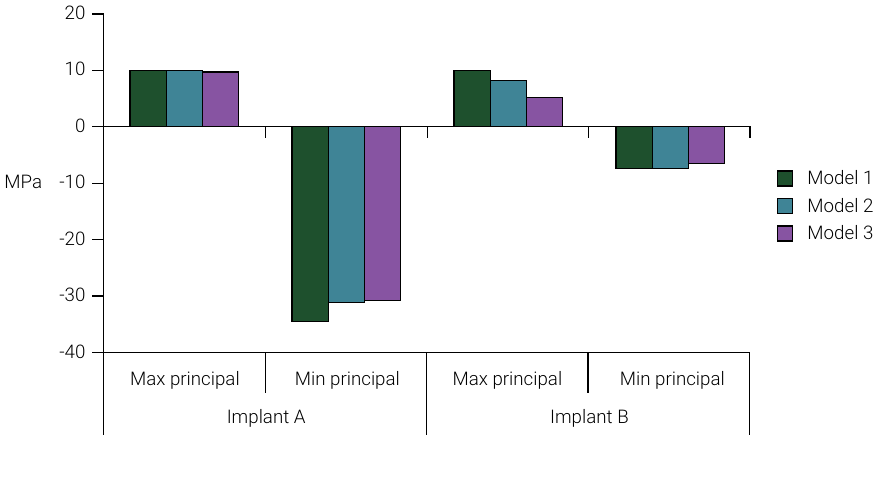
Table 2. Comparison of oblique loading (maximum and minimum principal stress) to implant A and B, on the three full-arch prosthesis